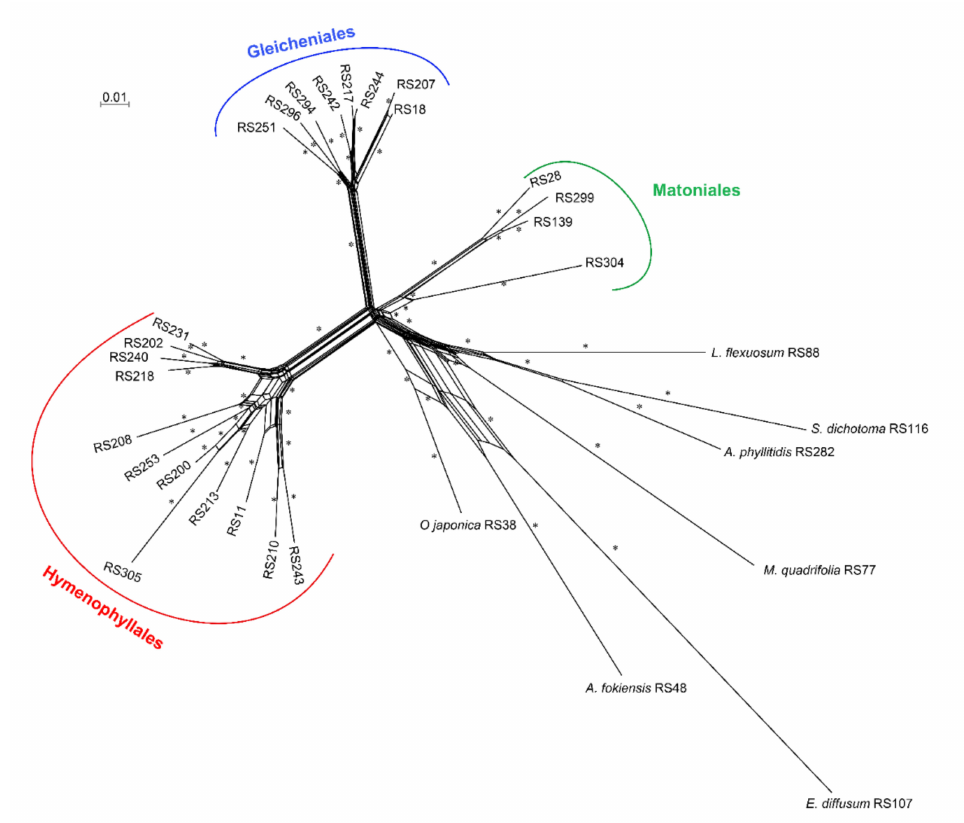
Figure 5. Reticulate evolution in the early leptosporangiate ferns. The asterisk (*) indicates bootstrap support (BS) values of